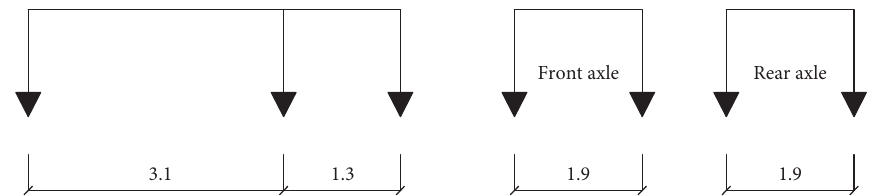
Figure 13: Wheelbase of the vehicles used for static load tests (m). Table 4: Theoretical and actual weights.